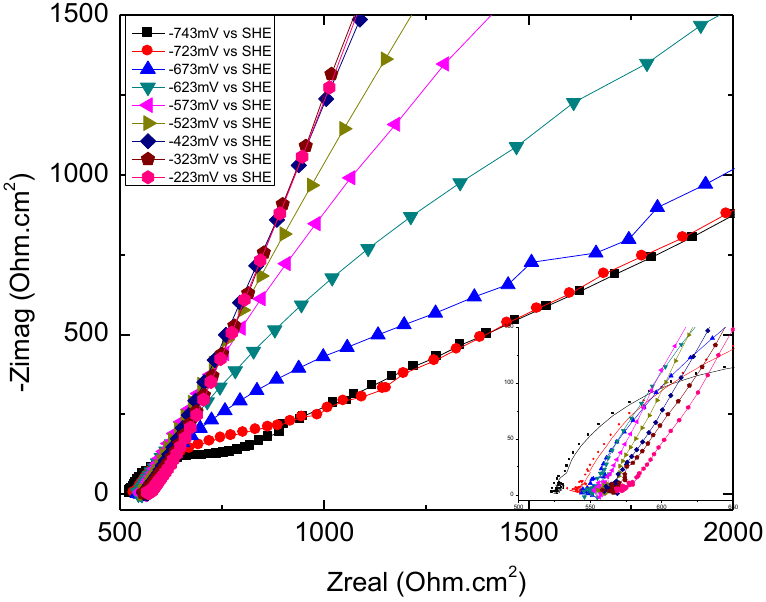
Figure A4. The curvatures of the Nyquist plots of − 623 mV and − 573 mV in the higher range of frequencies that are depicted represent portions of circular arcs.